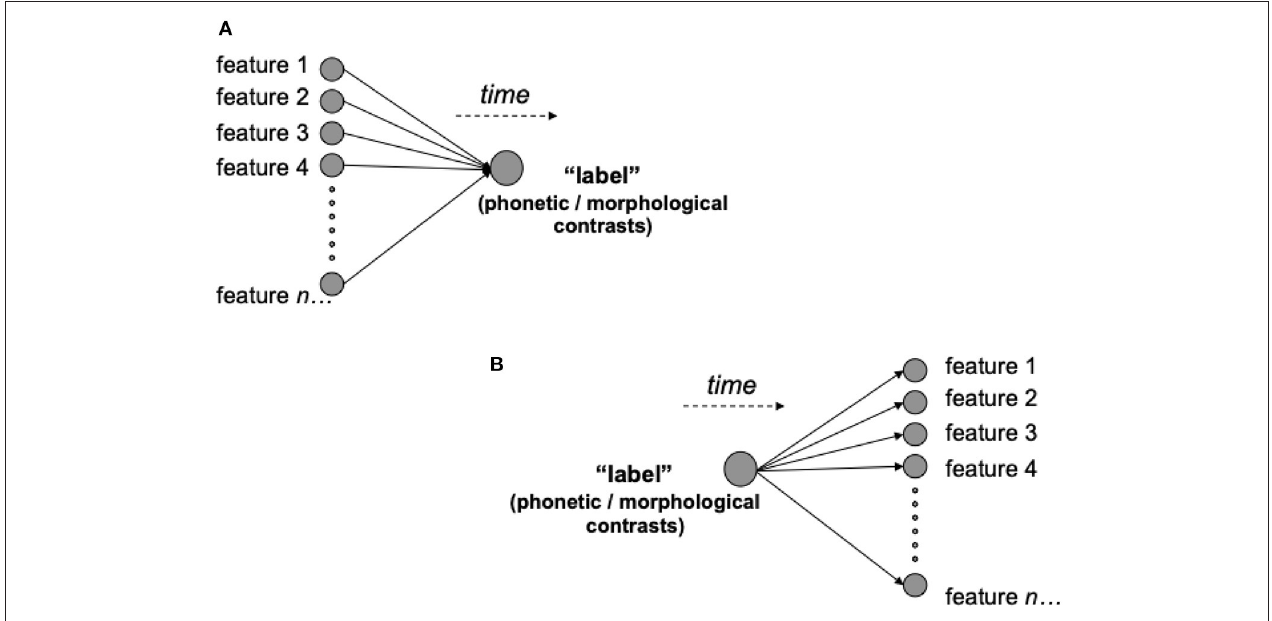
FIGURE 1 | The possible predictive relationships labels (in morphological terms, series of words and affixes) can enter into with the other features of the world (or other elements of a code). A feature-to-label relationship (A) will facilitate cue competition between features, and the abstraction of the informative dimensions that predict morphological contrasts (e.g., nouns and plural affixes) in learning. By contrast, a label-to-feature relationship (B) will be constrained to simply learning the probability of each feature given the